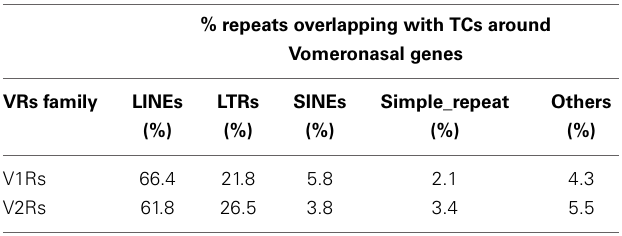
Table 2 | Classes of Repeat Elements overlapping with TCs mapping around V1R and V2R